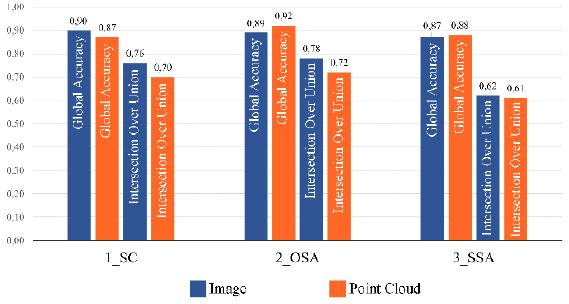
Figure 8 . Comparison between a) the Ground Truth point cloud, b) the Predicted point cloud.